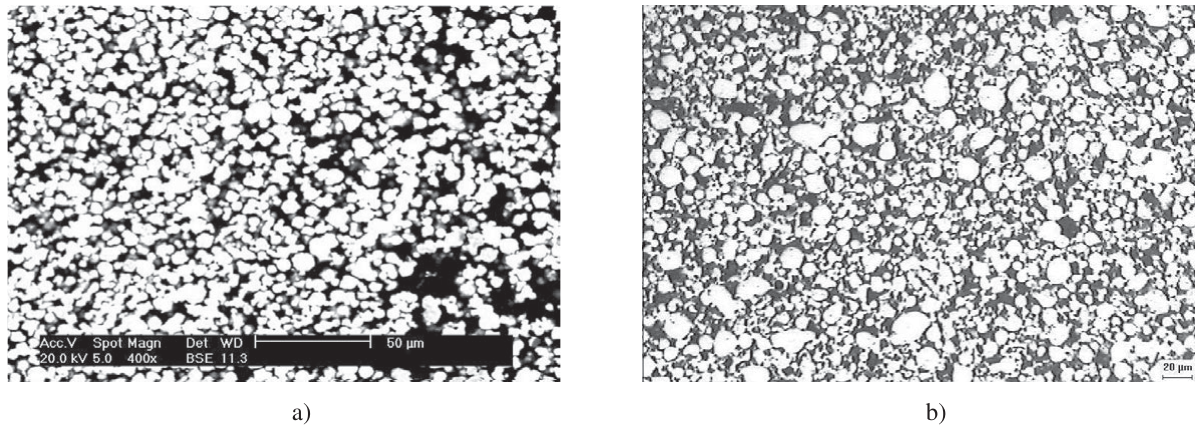
Figure 5. a) Image of a nickel sample sintered at 700 °C/30 min obtained by SEM; b) image of a stainless steel sintered at 1000 °C/30 min obtained by optical microscopy.